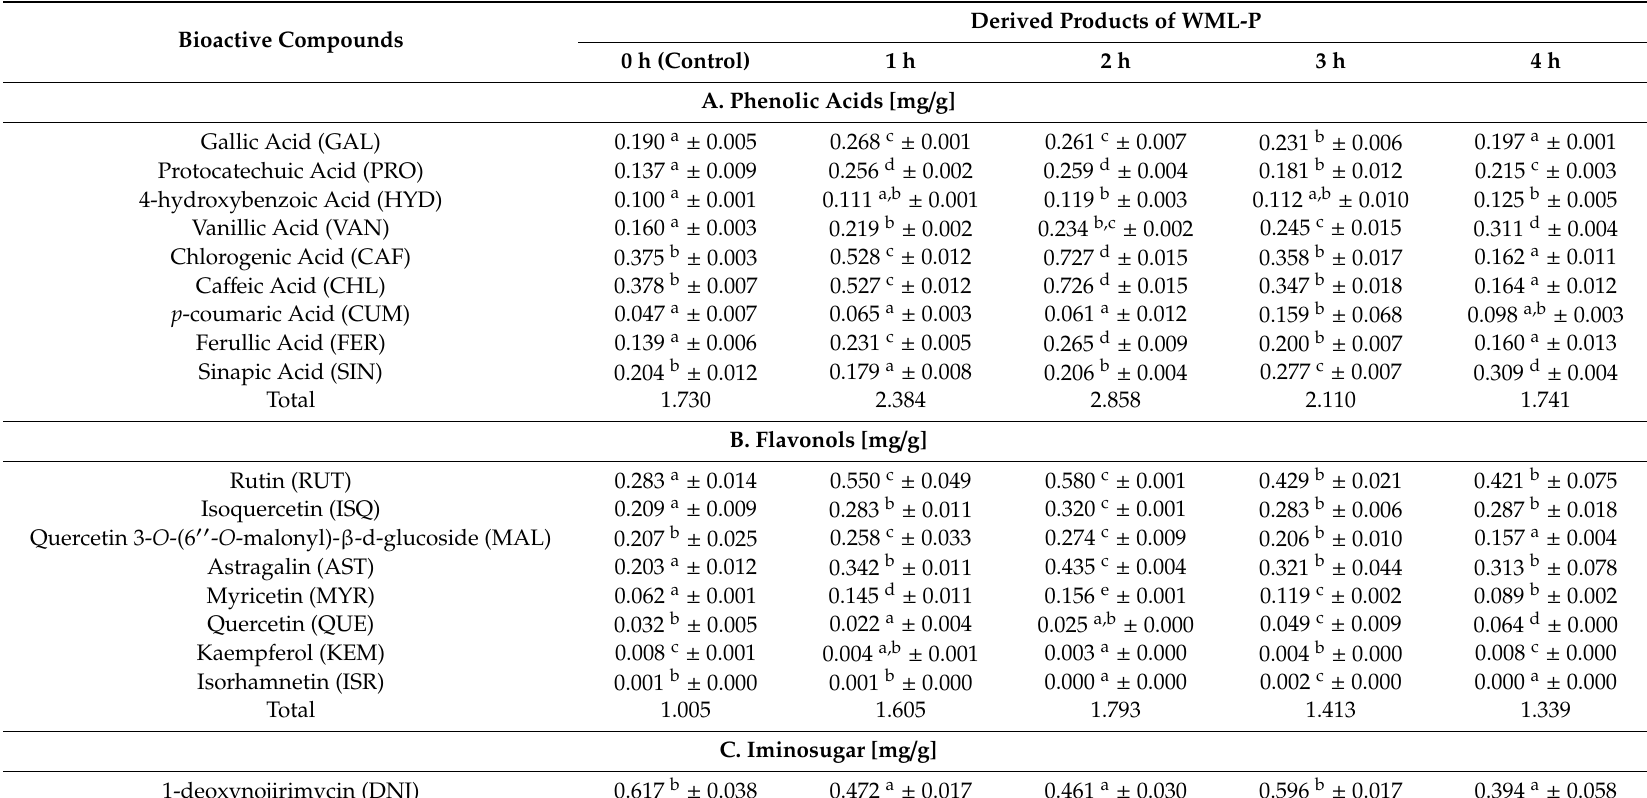
Table 3. The content of bioactive compounds in dried Polish var. zolwinska wielkolistna leaves (WML-P) before (control) and after